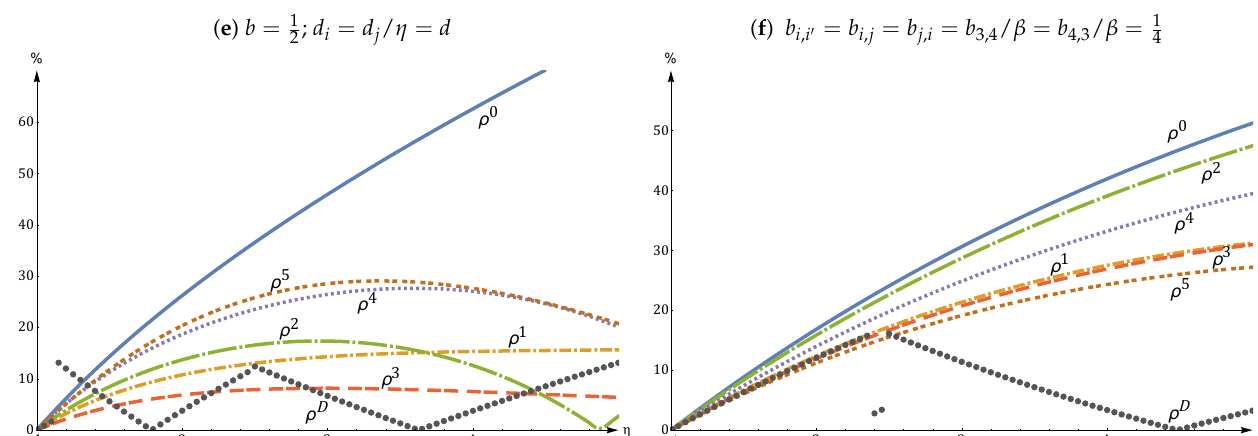
1 Figure 2. Normalized mis-allocation M ρ implied by market share heuristics and using dichotomous simple game approxi- mations in a linear Bertrand model with asymmetric firms, letting i ∈ { 1,2 } and j ∈ { 3,4 } and respectively deviating from symmetric benchmark parameters a = 30, γ = 2, d = 3, n = 4, b = d / ( 3 α ) as indicated in the respective panels ( a – f ). The black dotted line reflects the use of dichotomous simple game